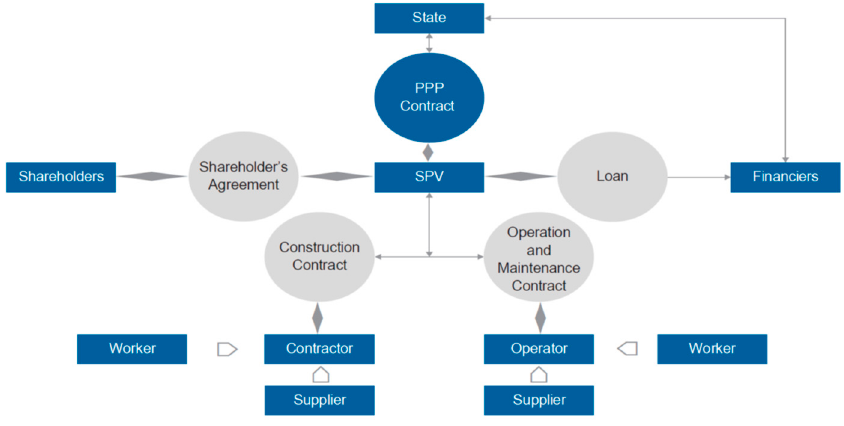
Figure 5. Primary contractual relations in a PPP contract. Source: Heydari et al. [7].